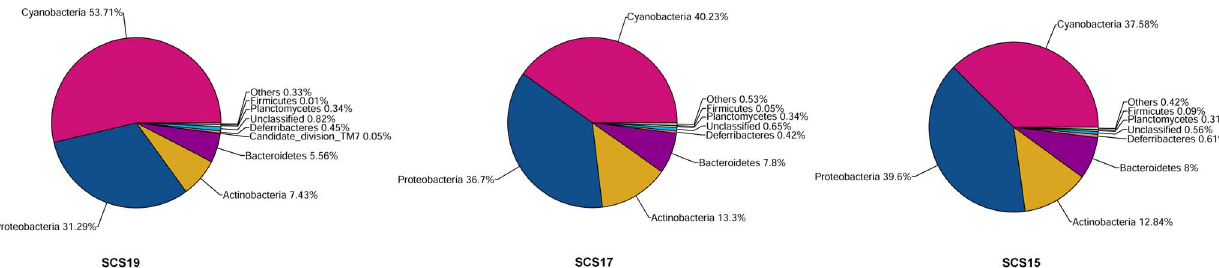
Figure 2. Bacterial compositions of the different samples in the nSCS.